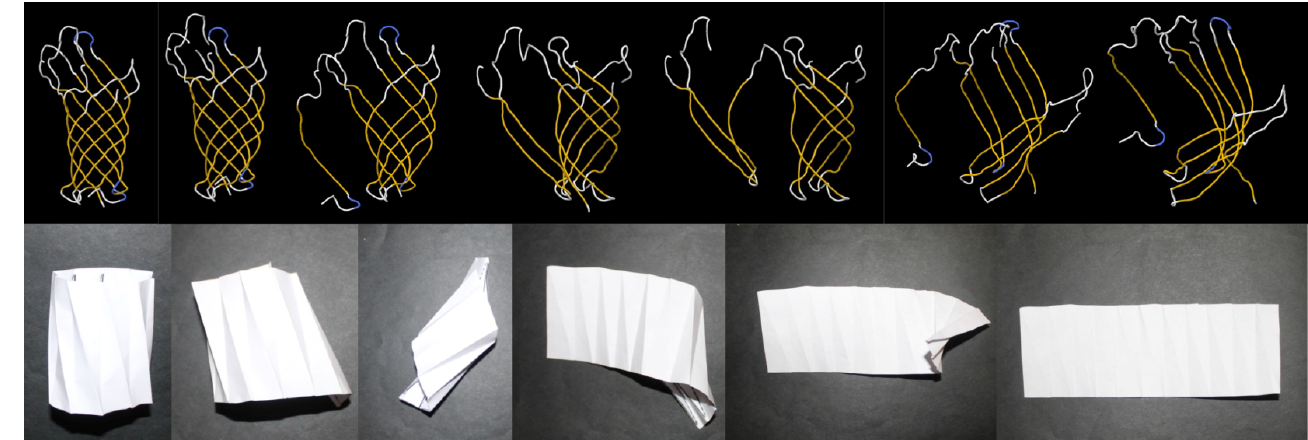
Figure 1. Folding processes of proteins ( top ) and origami ( bottom ).